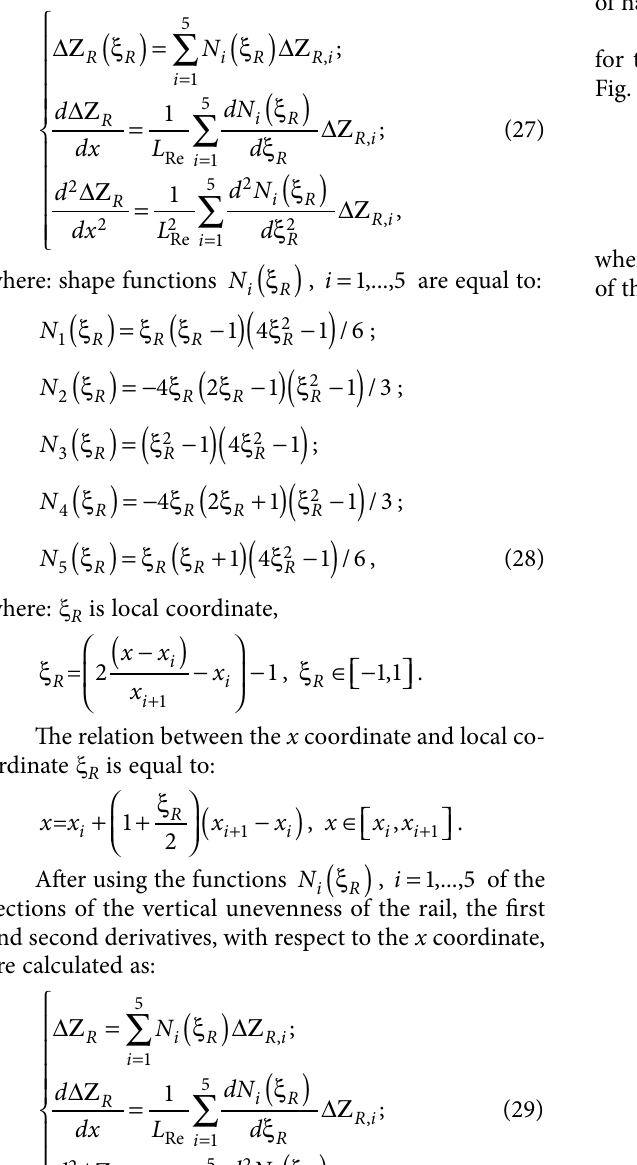
Fig. 3. Vehicle’s wheel flat (a) and calculation scheme for the profile of the vehicle’s wheel flat